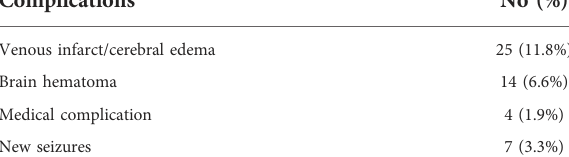
TABLE 2 The complications among 212 patients with parasagittal meningiomas.